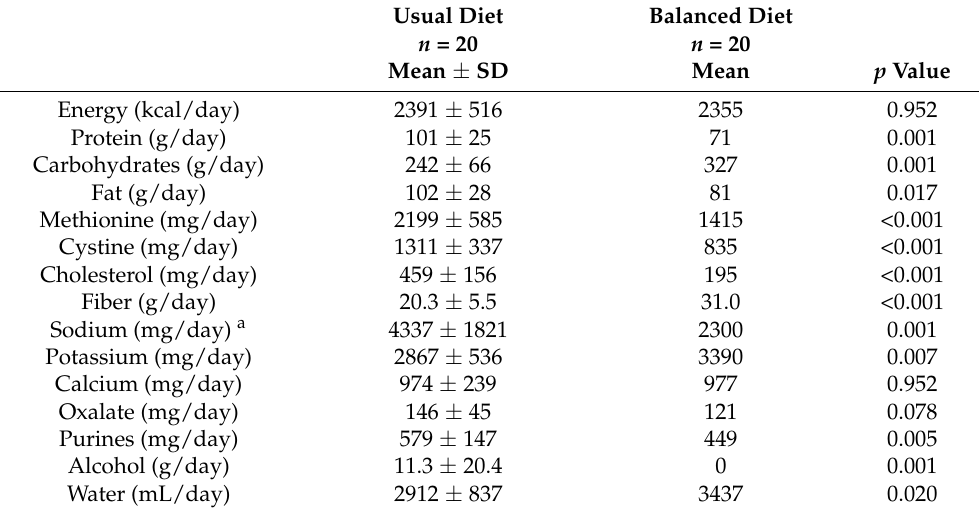
Table 4. Nutrient intake under the usual diet and balanced mixed